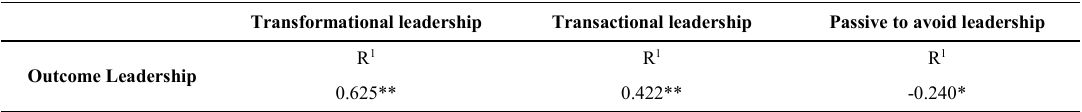
Table 7. Correlation Leadership type vs. Outcome Leadership.